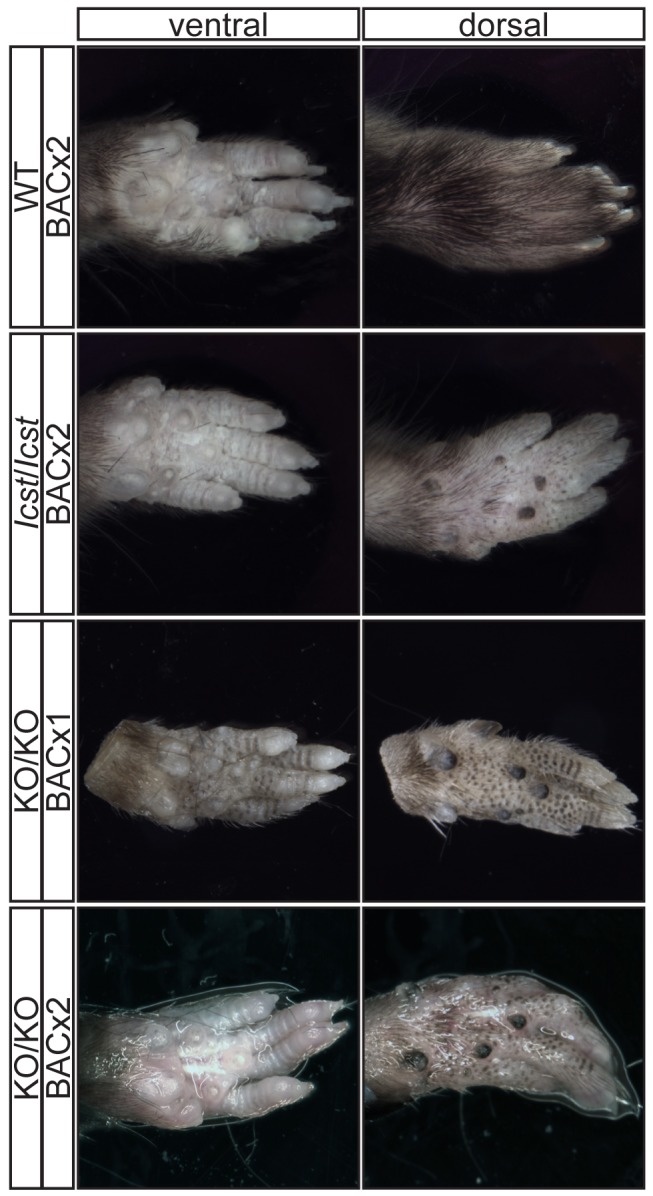
Forepaw phenotype of transgenic rescue mice.Pictures of the ventral and dorsal sides of forepaws from wild-type (WT), Lmx1bIcst
/Icst (Icst/Icst) and Lmx1bKO/KO (KO/KO) mice are shown and whether the BAC transgene is hemizygous or homozygous is indicated (BACx1 or BACx2). The ventral side of the paw is normal for all the rescue mice. The dorsal surface of all the homozygous mutant paws appears ventralised with pigmented footpads and no hair. The ages of the mice shown are as follows. Top two rows, P14; third row P26 and bottom row P35.